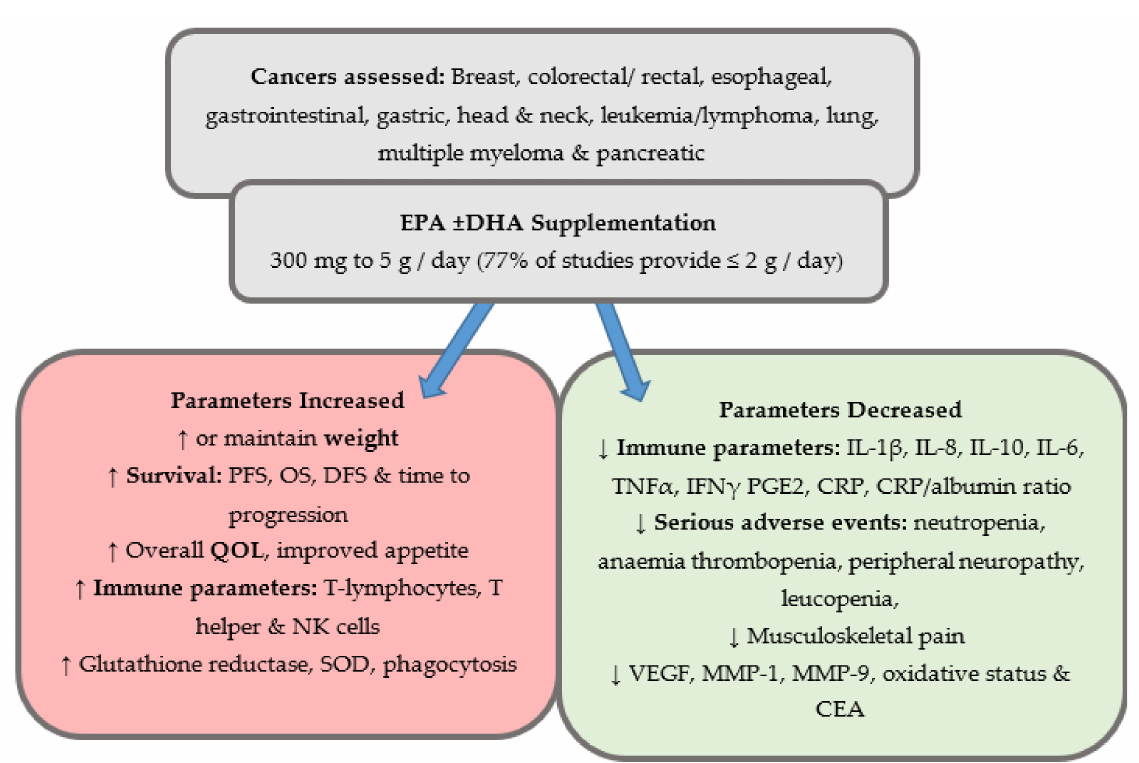
Figure 2. Overview of outcomes reported on the effects of n-3 supplementation compared to control or baseline status in clinical trials. Abbreviations used: CEA, carcinoembryonic antigen; CRP, C-reactive protein; DHA, docosahexaenoic acid, DFS, disease-free survival, EPA, eicosapentaenoic acid, IFN, interferon; IL, interleukin; MMP, matrix metalloproteinase, OS, overall survival, PGE2, prostaglandin E2; PFS, progression-free survival; QOL, quality of life; SOD, super oxide dismutase; TNF, tumor necrosis factor; VEGF, vascular endothelial growth